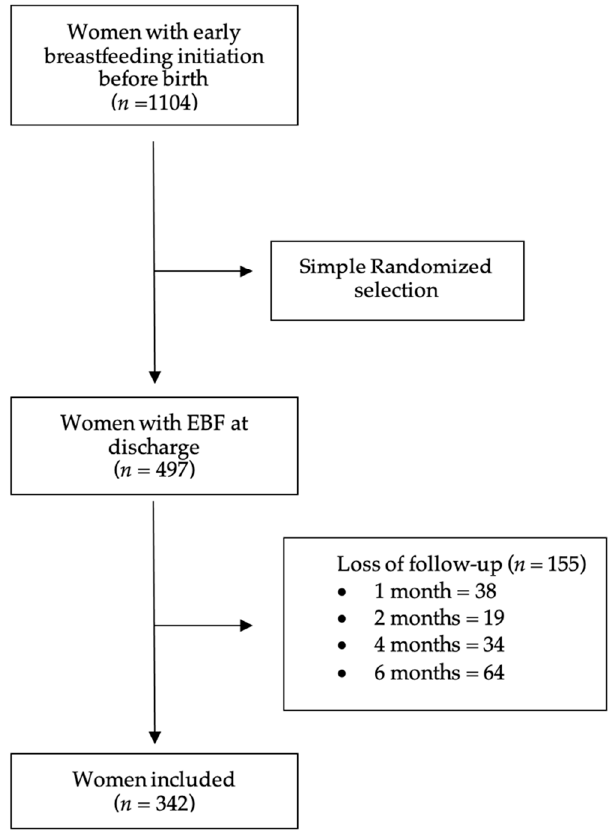
Figure 1. Flow chart of the study. MBF: exclusive breastfeeding.